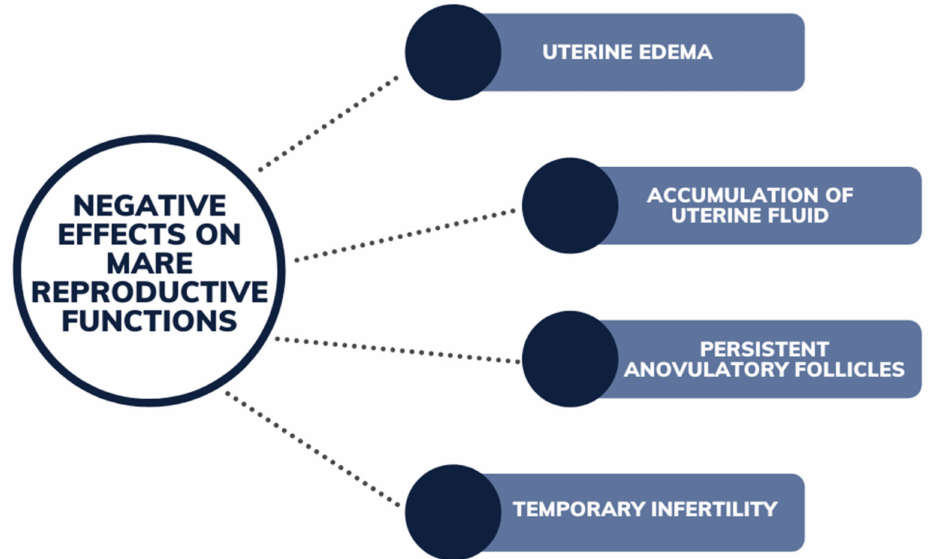
Figure 7. Negative effects of phytoestrogens on mare reproductive functions induced following ingestion of legume pasture